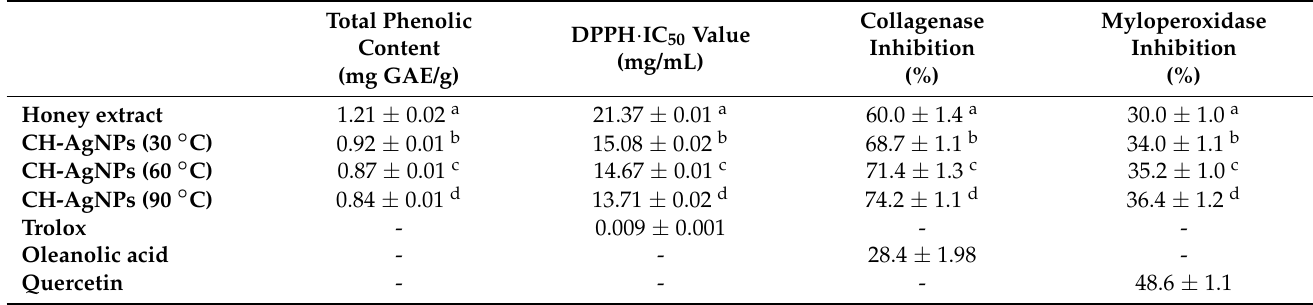
Table 3. Biochemical and enzyme inhibition properties of honey extract and